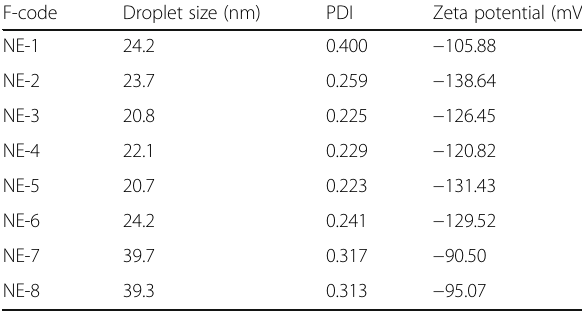
Table 3 Mean droplet size distribution, polydispersity index